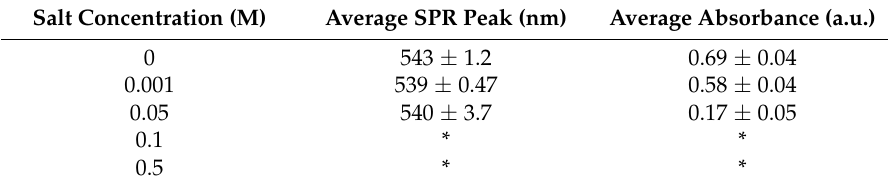
Table 2. The average SPR peak and absorbance as determined by UV–vis spectroscopy for 5 mg/mL PDADAMAC-coated AuNP.